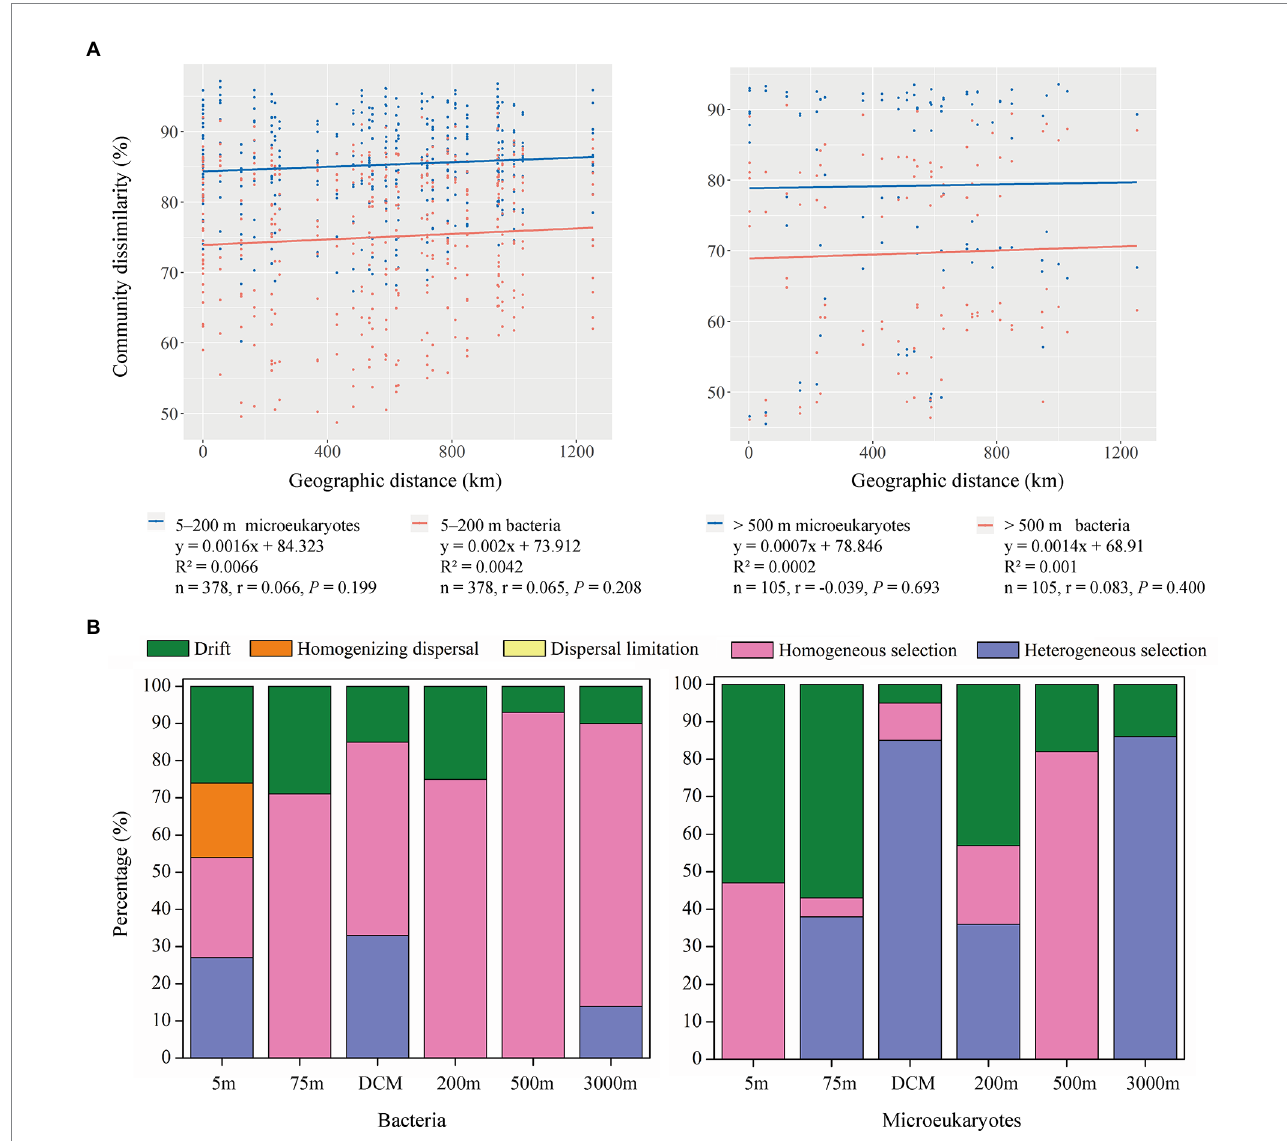
FIGURE 4 (A) Spearman’s rank correlations between the Bray–Curtis dissimilarity of microeukaryotic (blue dots and line) and bacterial (red dots and line) communities and geographic distance in the 5–200 m and > 500 m layers, the n is the number of comparisons. (B) Relative importance of ecological processes in shaping the bacterial and microeukaryotic communities across six